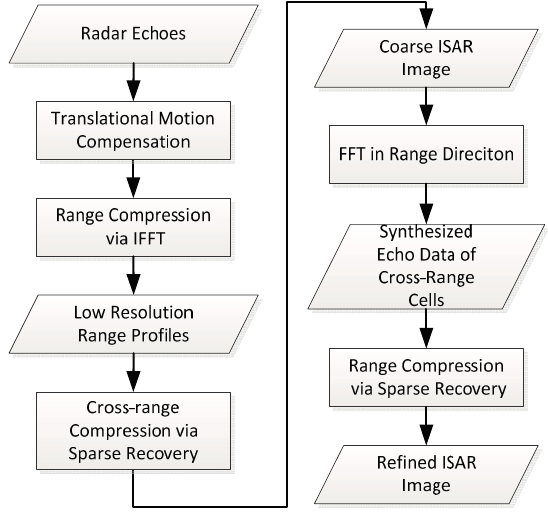
Figure 4. Block diagram of the proposed FSI